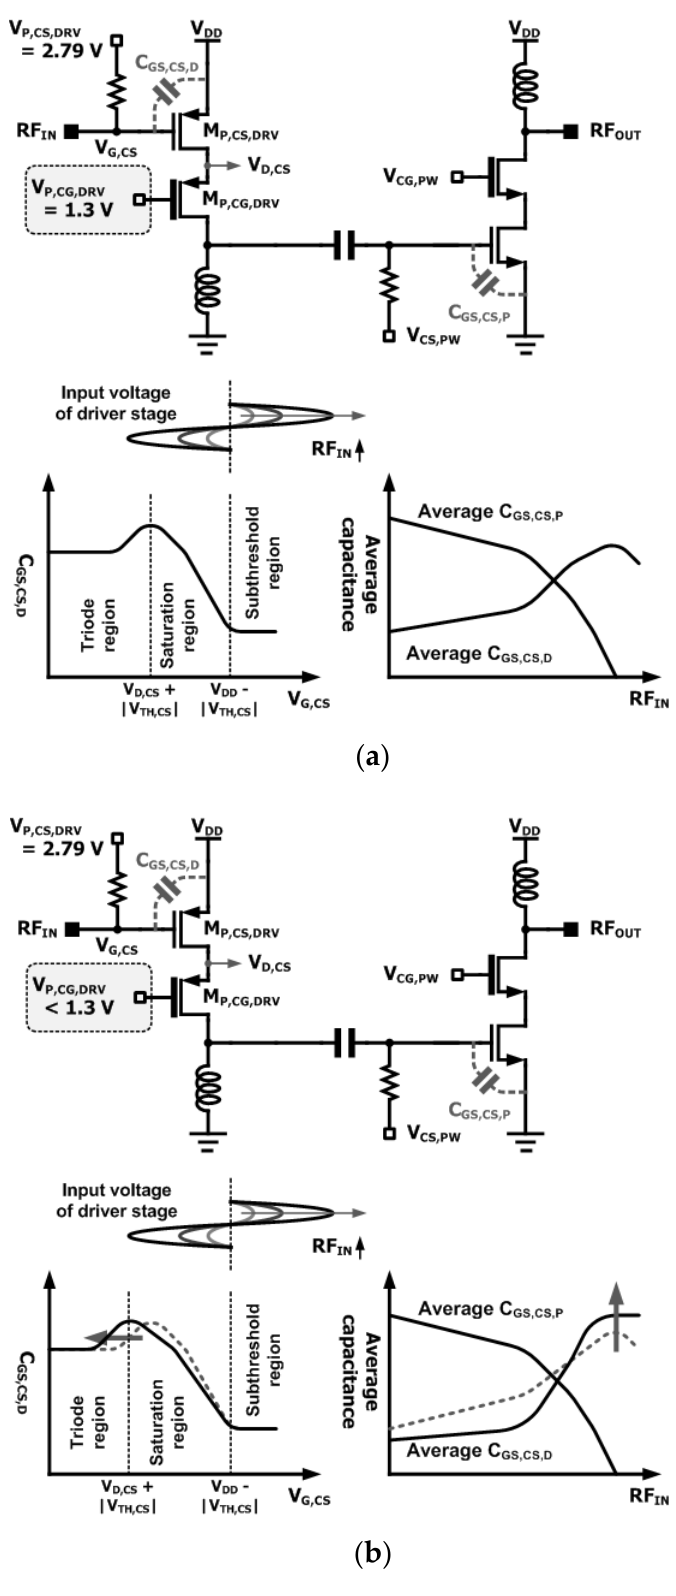
Figure 11. Conceptual parasitic capacitances of power and driver stages (V DD = 3.3 V): ( a ) 2.79 V of V P,CS,DRV , ( b ) decreased value of V P,CS,DRV .